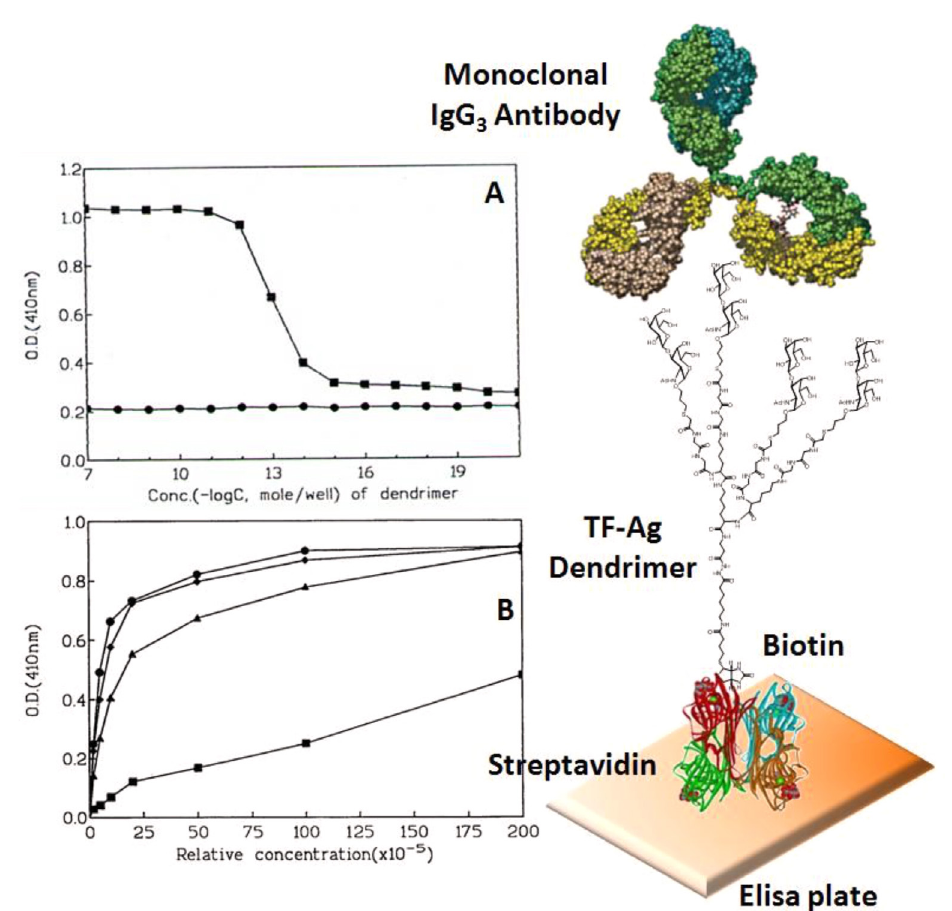
FIGURE 7 – Panel A: EIA using TF-Ag L-lysine tetramer (  ) and biotin labeled T-Ag tetramer (  ) versus indirect mouse IgG capture by streptavidin coating. Peroxidase –labeled goat anti-mouse IgG and ABTS-H EIA showing the coating properties of PAMAM-based T-Ag dendrimers ( 13-16 ) towards mouse IgG. Dendrimers: dimer (  ), tetramer (▲), 16-mer (  ), and 32-mer (  ). Peroxidase-labeled goat anti-mouse IgG and ABTS-H